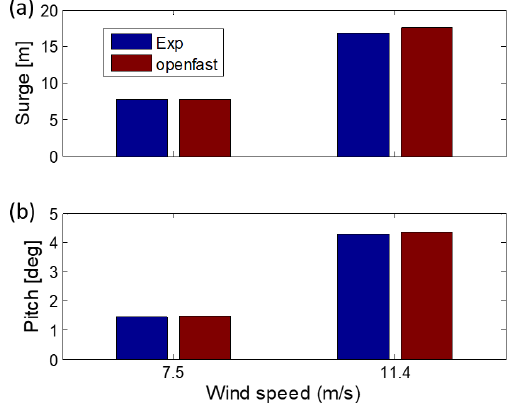
Figure 6. Steady-state response comparison between experiments (improved SiL) and OpenFAST simulation for (a) surge and (b) pitch